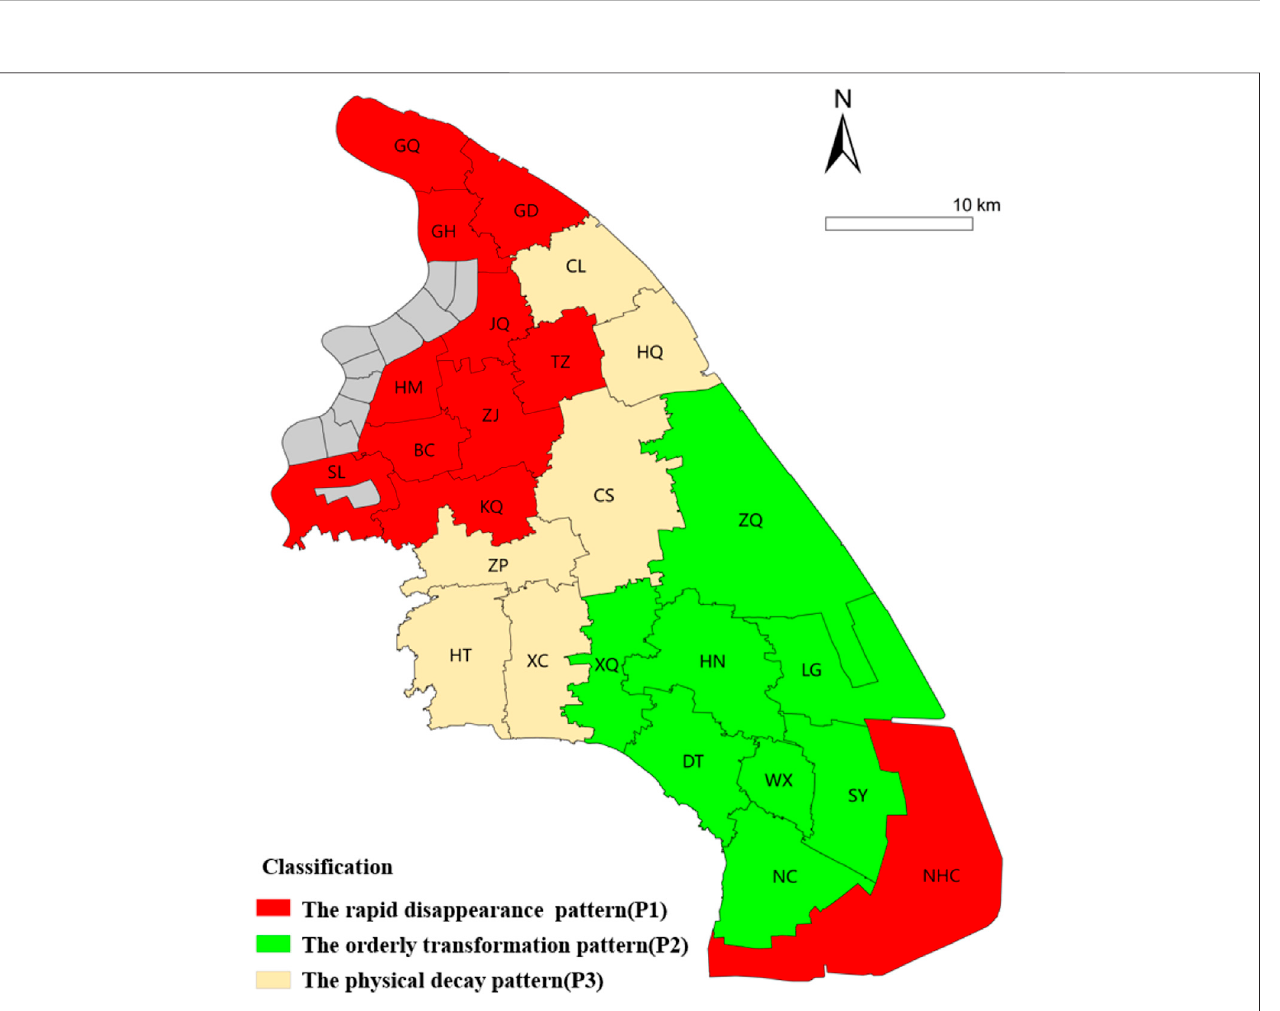
FIGURE 7 | Spatial differentiation of rural settlements transformation